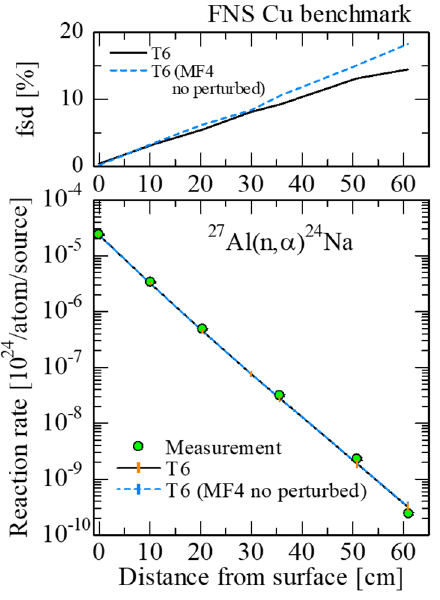
Fig. 7. Comparison of 27 Al(n,  ) 24 Na reaction rate distribution and the standard deviation between T6 and the result ignoring perturbation of angular